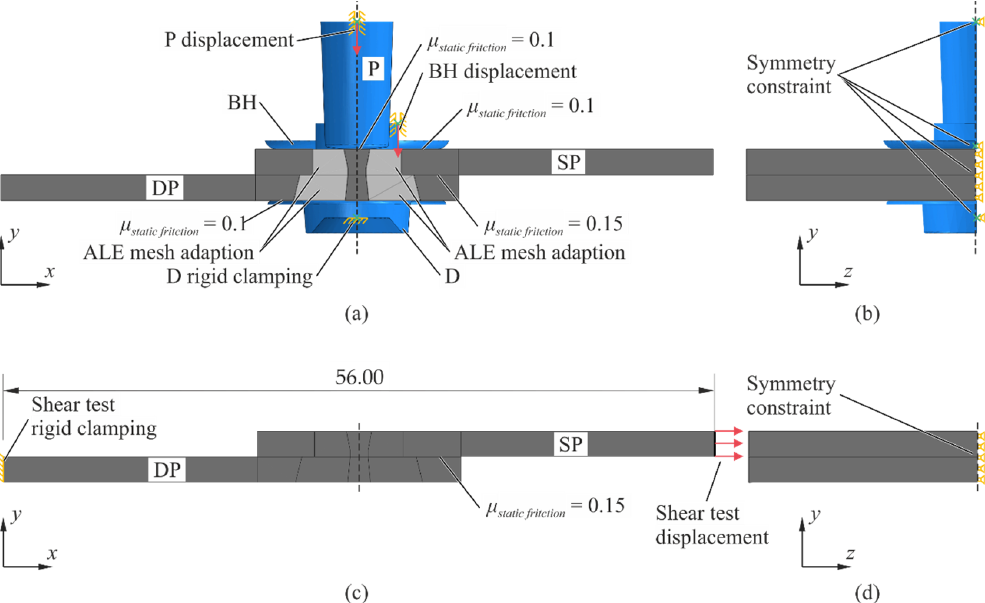
Figure 3. Set-up of the 3D numerical model for the clinching process ( a , b ) and for the lap shear test ( c , d ). The sheets (gray), the areas of Arbitrary Lagrangian–Eulerian (ALE) mesh adaption (light gray) and the tools (blue) are shown.